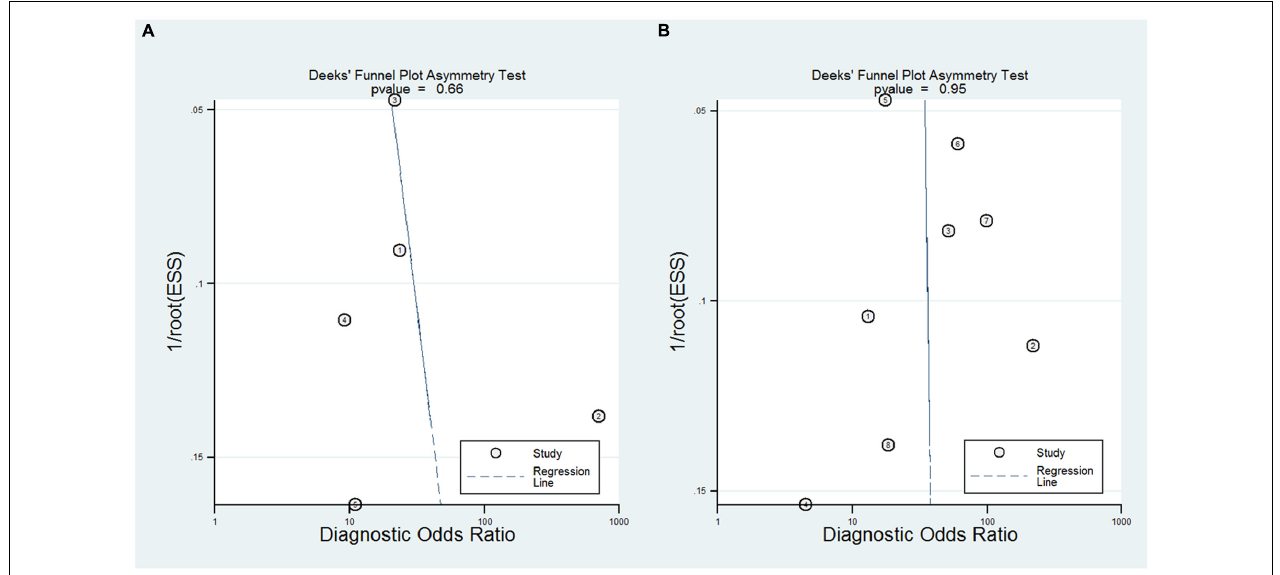
FIGURE 6 | The Deeks’ test of the diagnostic meta-analysis [(A) NFL and (B)